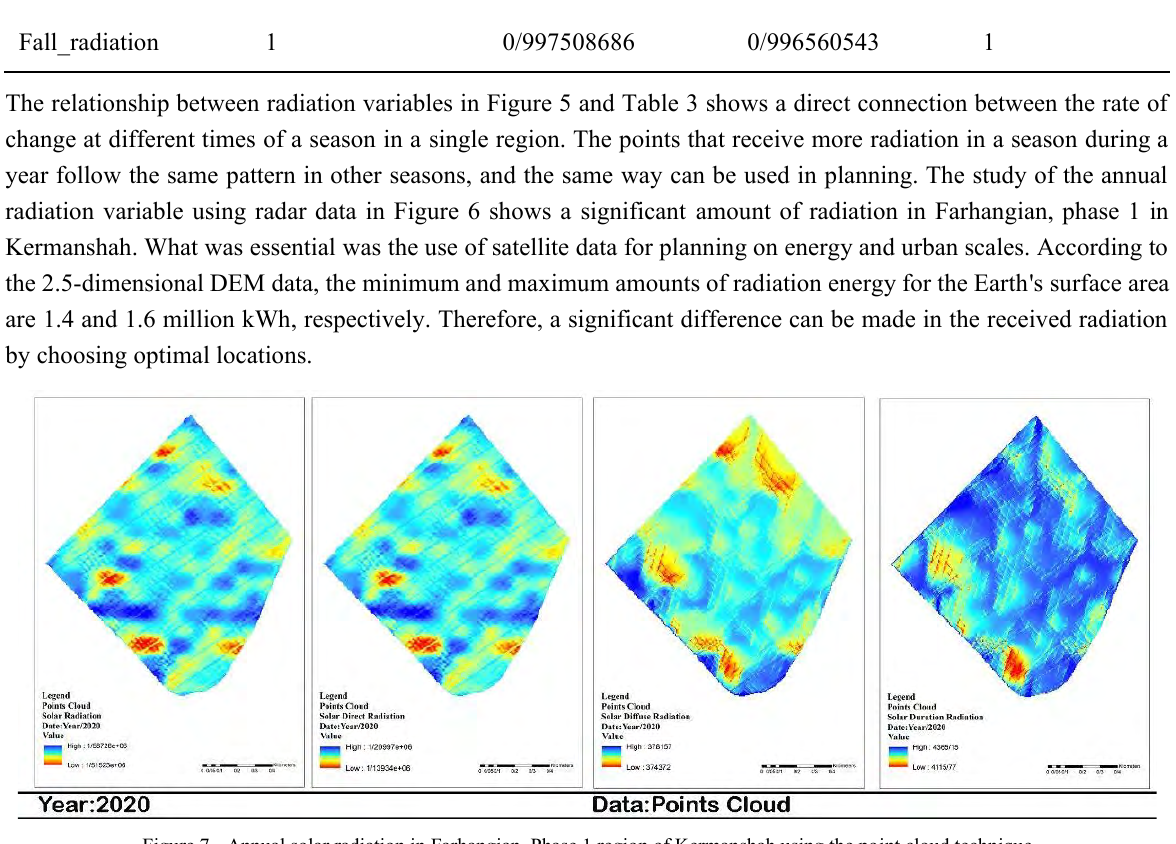
Figure 7 - Annual solar radiation in Farhangian, Phase 1 region of Kermanshah using the point cloud technique Annual data on solar radiation in different modes confirmed the importance of solar radiation hours during a year.